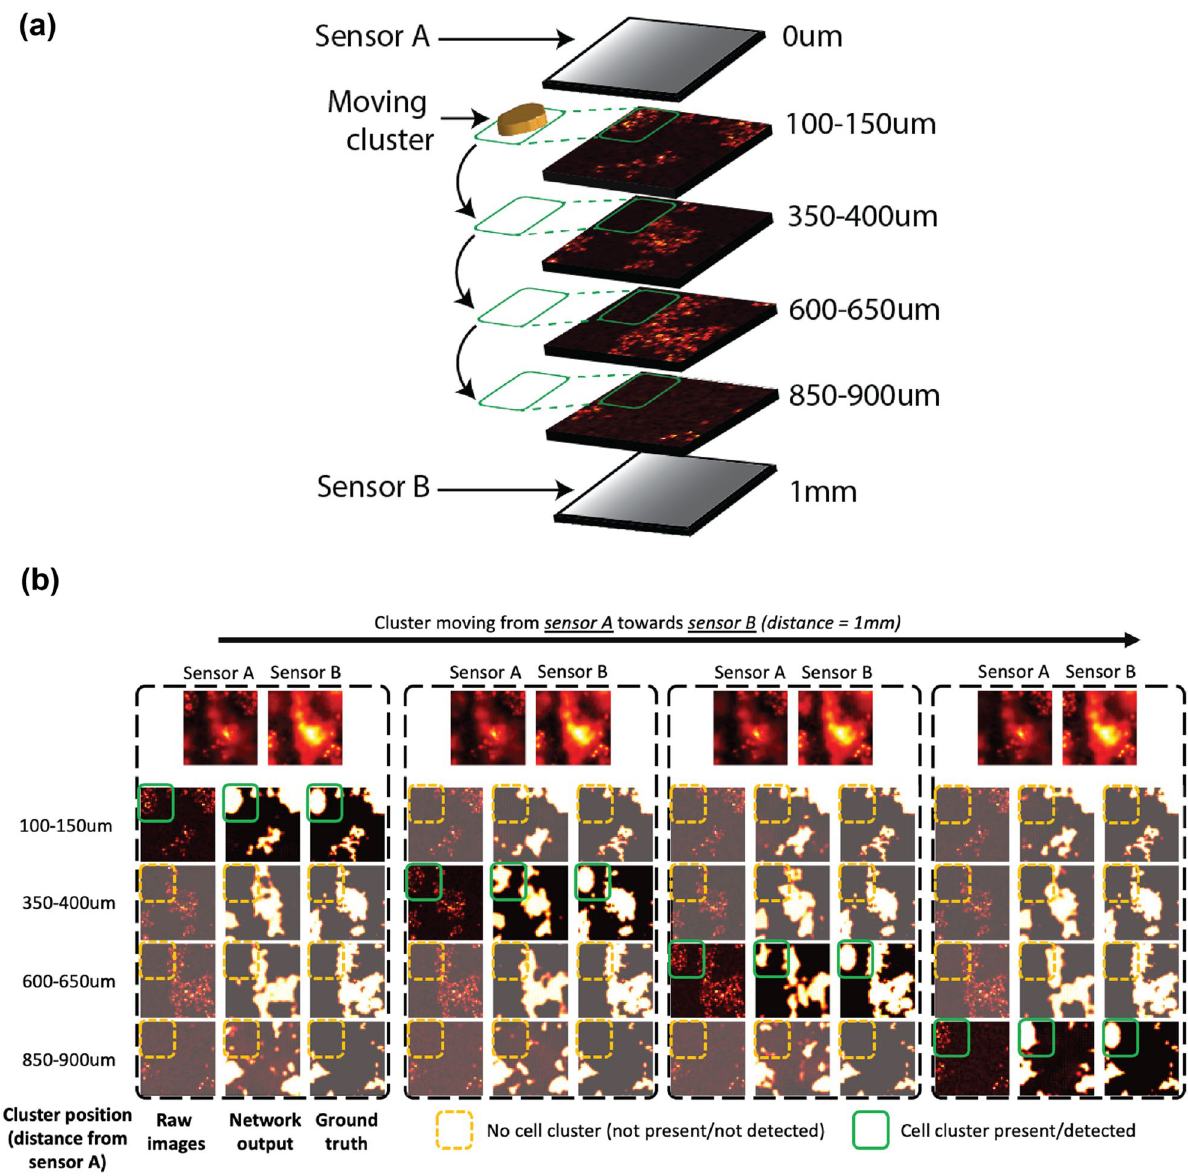
Figure 5. ( a ) Test setup for modeling dynamics of a moving cell cluster. ( b ) Outputs of the compounded module with the moving cell foci at each layer including the deblurred images at each depth, the two sensor images captured that serve as input to the module, the network outputs and the ground truth cell maps at each number of cancer cell slides. These specimens have first been imaged on high-resolution fluorescence microscope (shown in the first column in Fig. 7), after which each one has been assigned a randomly selected depth and was applied the corresponding PSF. After applying the PSF, all 4 layers were combined (added) to generate the sensor image. A similar procedure is also carried out for the second sensor. The sensor images obtained are shown in the second column of Fig. 7. The network output -illustrating regions where cells were detected in each layer- is shown in the third column, and an overlay composite image of the outputs with the microscope images is also shown in the rightmost column in Fig. 7, showing an almost perfect level of localized cell detection. An additional limitation of this work involves partial modeling of optical path non-idealities. While the PSF accounts for the optical divergence of the light path, it does not take account for the scattering and absorption of the tissue medium. A further enhanced version of the module can be trained on a dataset that incorporates the effect and impact of scattering, absorption, motion deformation, non-uniformity of the laser beam and addi- tive noise in the tissue as described in 43 . While an improvement, those effects can however largely be mitigated by using a longer wavelength process with the corresponding fluorophores, such as an ICG or IR-800 dye, as reported in 44–46 .